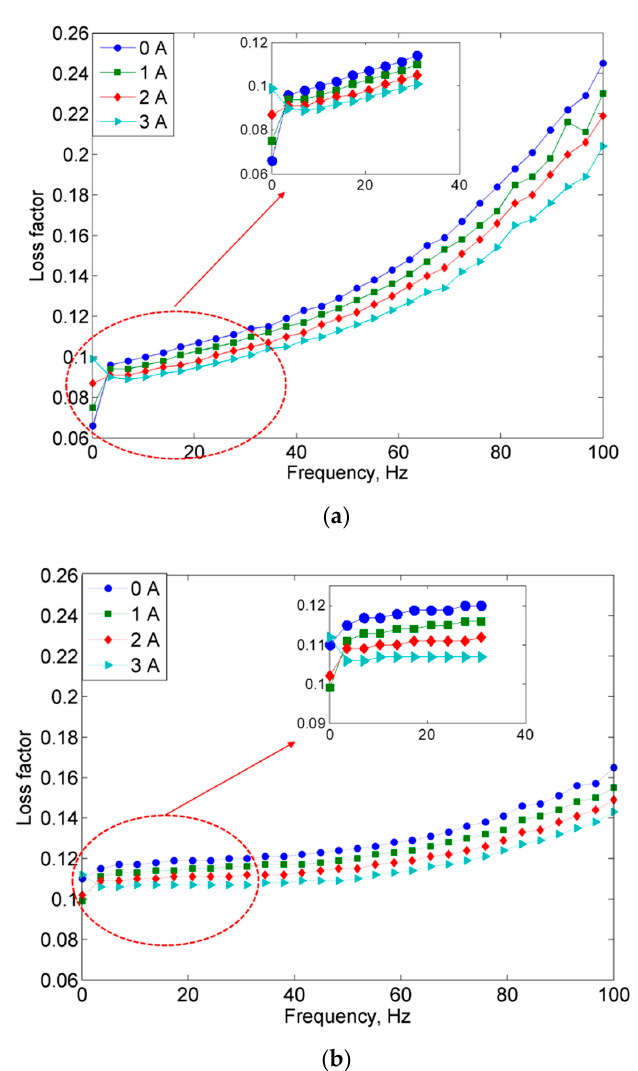
Figure7. Lossfactorvs. frequencyfor( a )MREwithnon-corrodedCIPsand( b Figure 7. Loss factor vs. frequency for ( a ) MRE with non-corroded CIPs and ( b ) MRE with corroded CIPs.